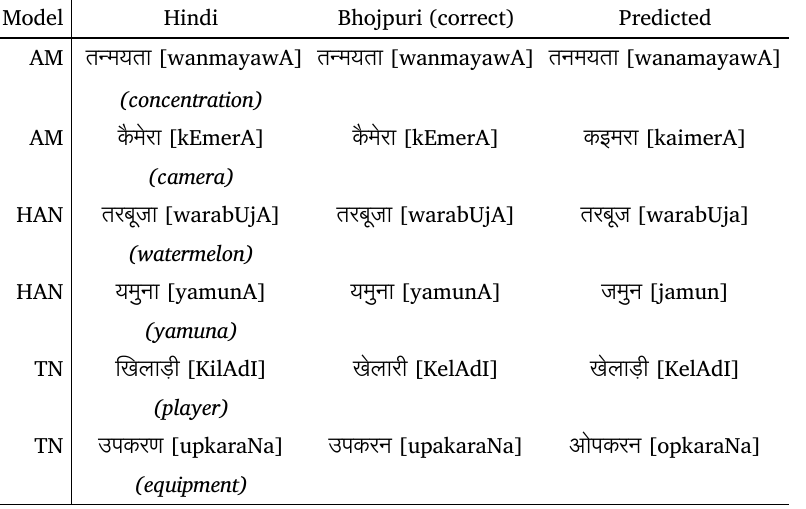
Table 14: Some sensible yet erroneous translations